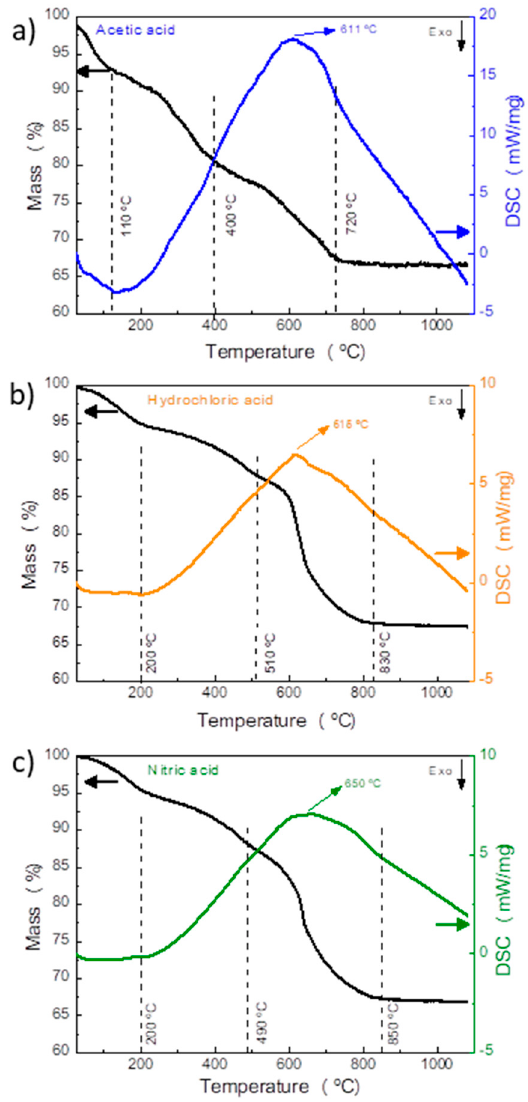
Figure 5. Thermogravimetric analysis and differential scanning calorimetry (TGA/DSC) curves of the as-synthesized nanostructures before calcination produced with ( a ) acetic acid, ( b ) hydrochloric acid and ( c ) nitric acid.